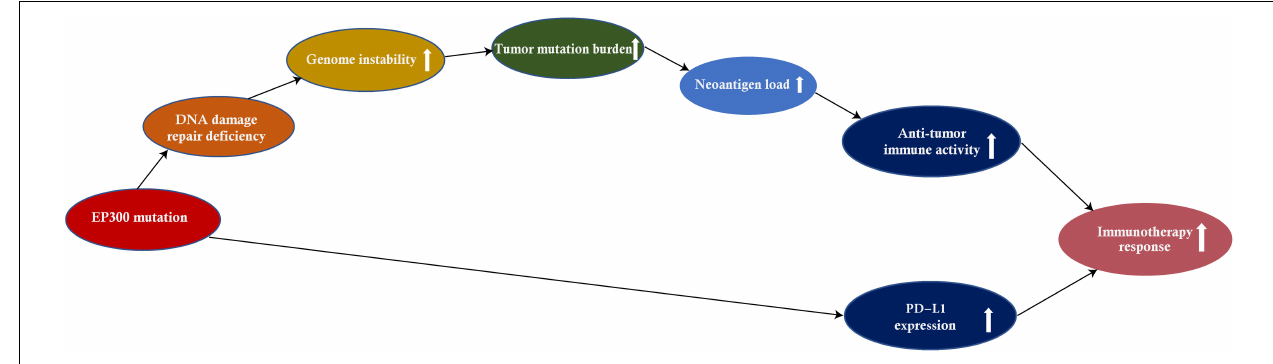
FIGURE 6 | The mechanism by which the E1A binding protein p300 ( EP300 ) mutation increases antitumor immunity and immunotherapeutic response in